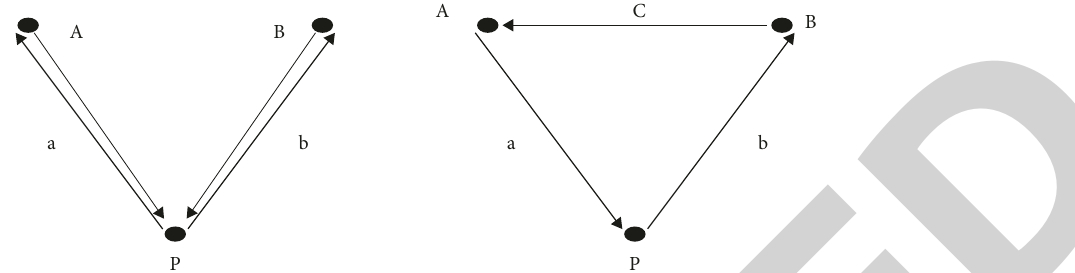
Figure 7: Display of optimized path of mileage saving